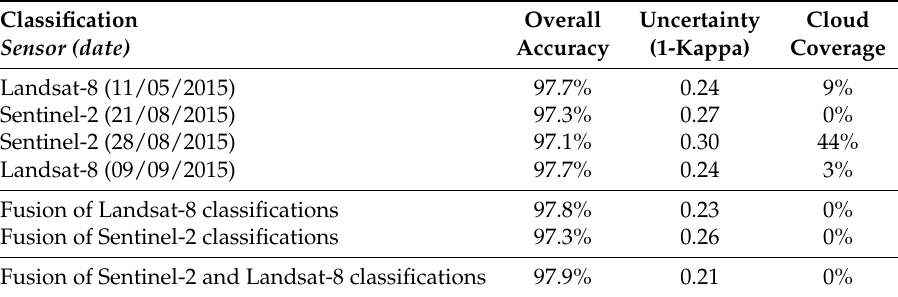
Table 3. Intermediate result for Rennes.